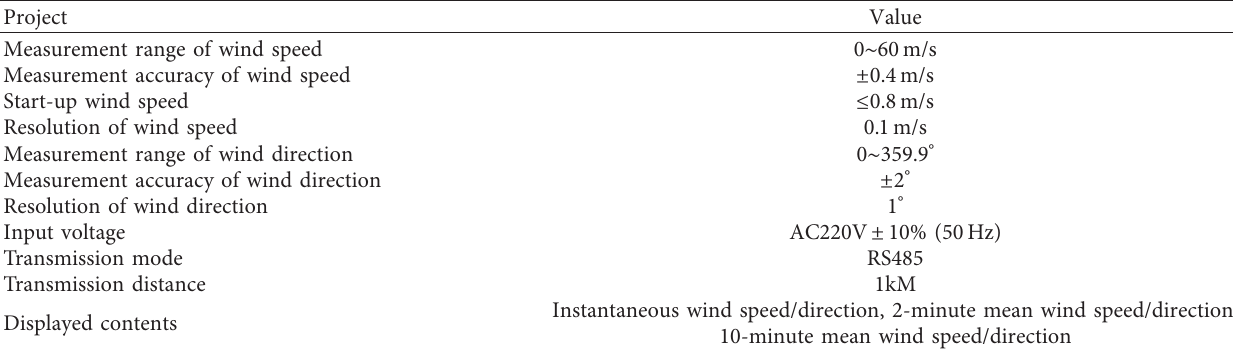
Figure 2: Anemometers layout. Table 1: Specific parameters of the WJ-3